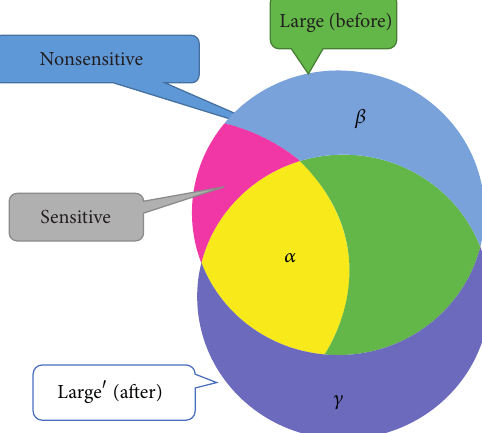
Figure 2: The entire flowchart of the genetic algorithm. the transactions from the original database as the optimal solution for a chromosome to be inserted into the database.